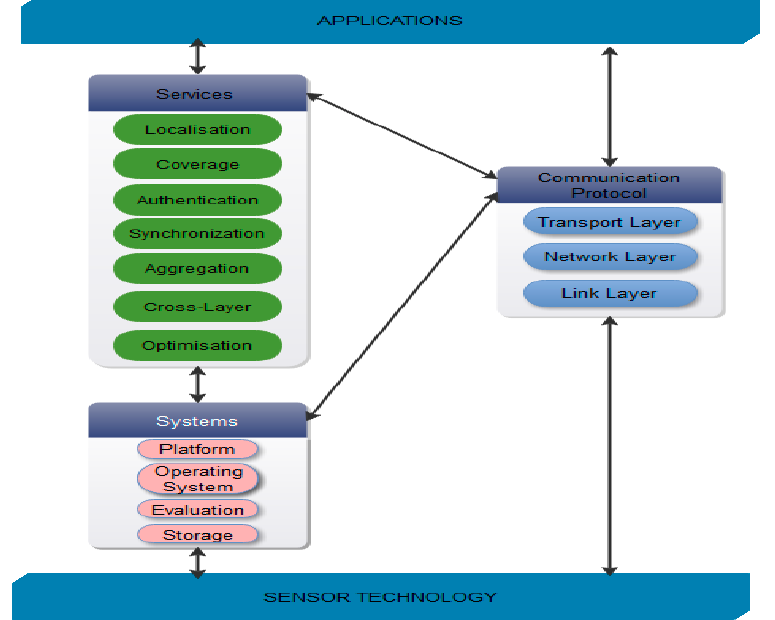
Figure 3. Various issues in a wireless sensor network (WSN)—Broad Classification.